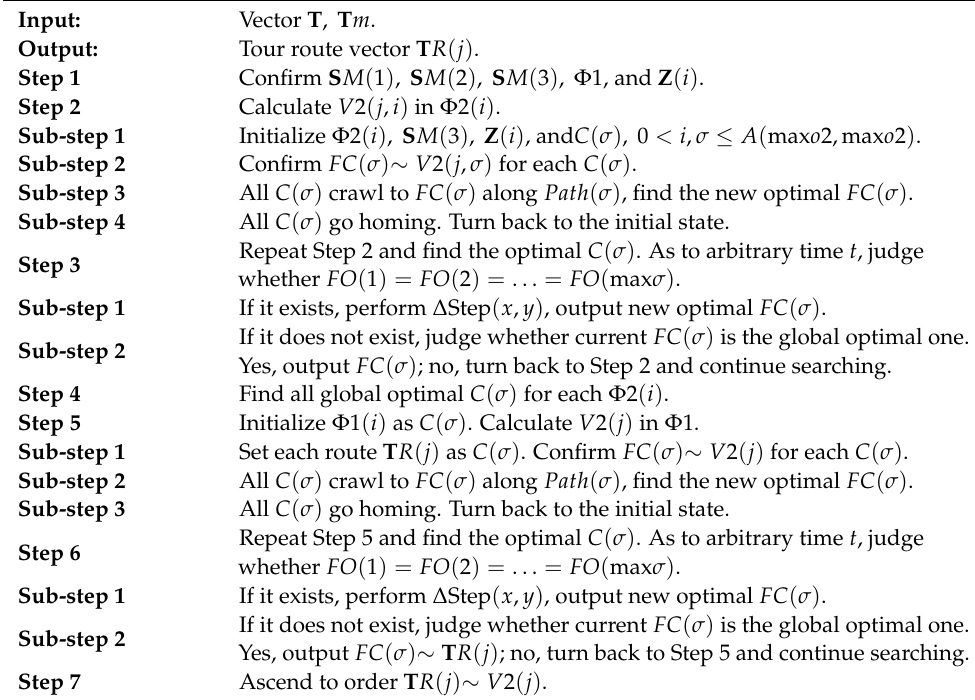
Algorithm 2 The water tour route algorithm based on the improved cockroach optimization